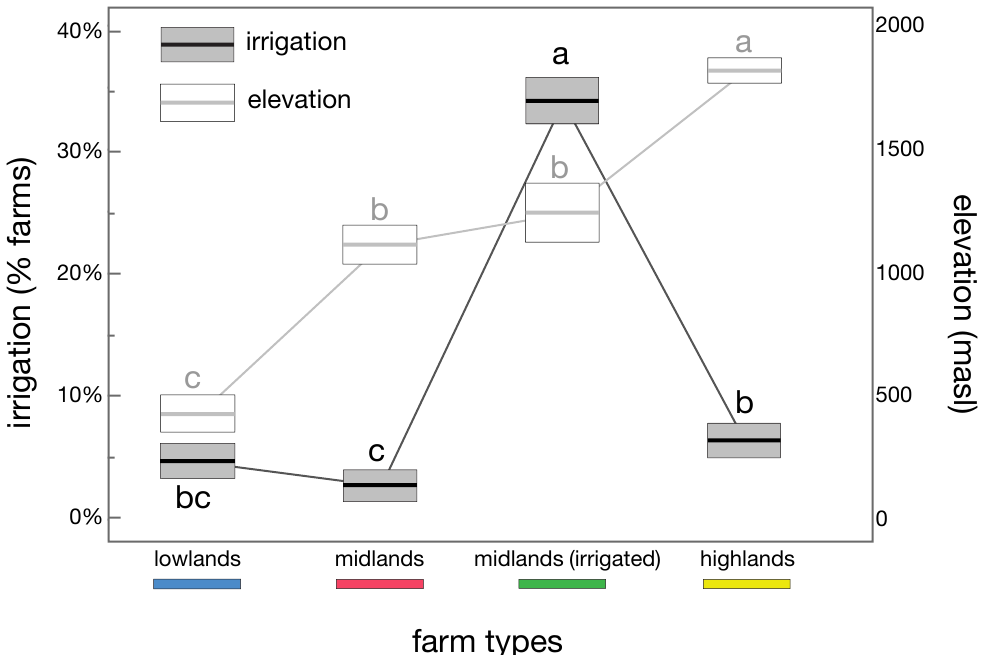
Figure 3. Farm type clusters (K-means) in the study area by the mean percent of farms in each municipality with irrigation and the mean elevation (centroid) of municipalities. Boxed areas represent 95% means confidence intervals. Letters (a,b,c) for significant differences were determined using Kruskal–Wallis and Dunn’s post-hoc tests (non-parametric), and Pearson’s Chi-squared tests (proportional) ( α = 0.05).